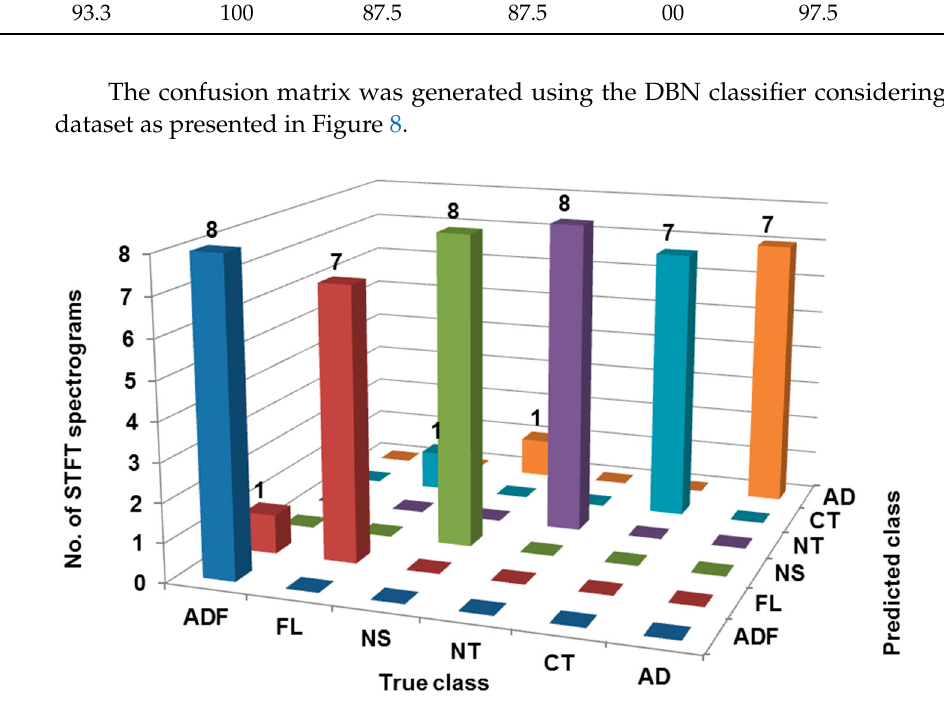
Figure 8. Confusion matrix considering test dataset.